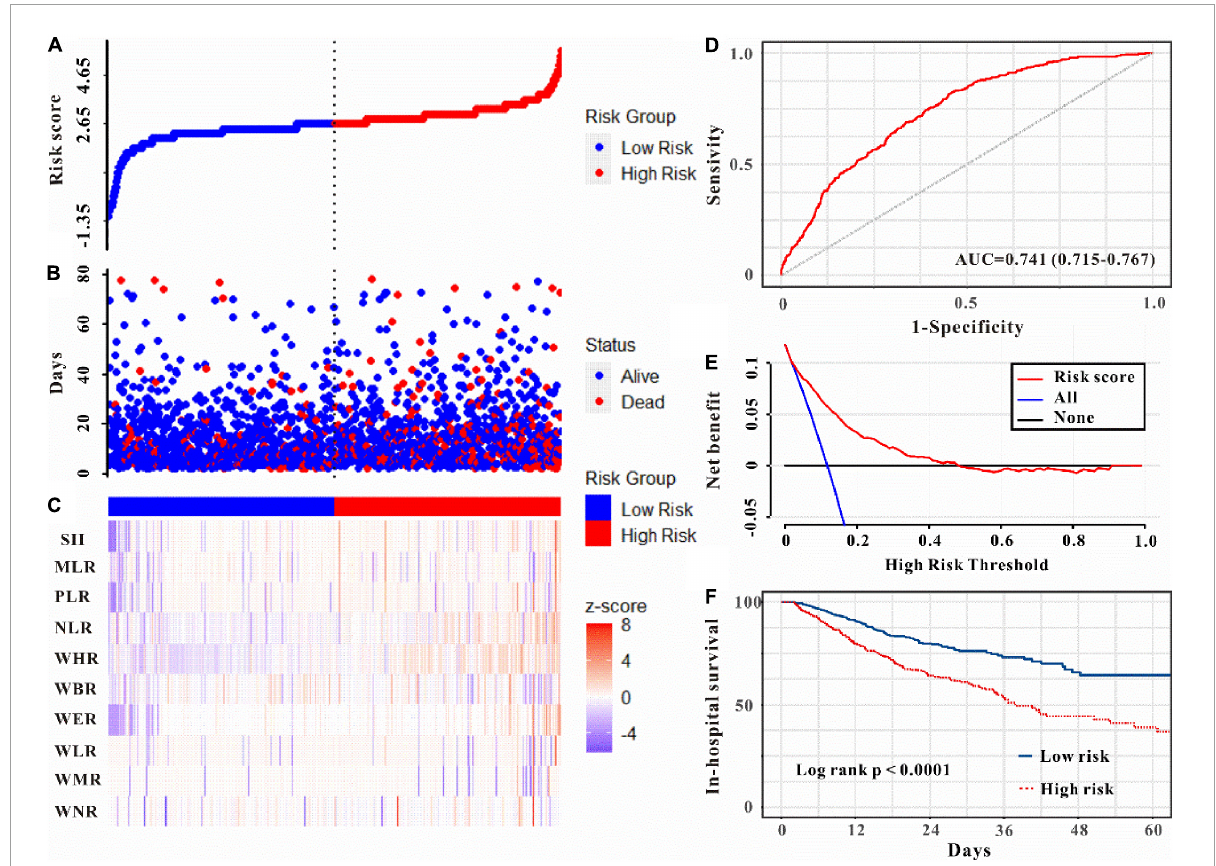
FIGURE6 Risk score was established to detect in-hospital mortality in critically ill patients with IS. All patients were distinguished into high and low risk based on the risk score (A) , the relationship between survival time and prognosis of patients in the two corresponding groups (B) , and the heatmap of inflammatory marks between the two groups (C) . Receiver operating characteristic (ROC) curve analysis of the risk score for in-hospital mortality (D) and decision curve analysis of the risk score for in-hospital mortality (E) . Kaplan–Meier curves show the in-hospital mortality of groups with different risks (F)